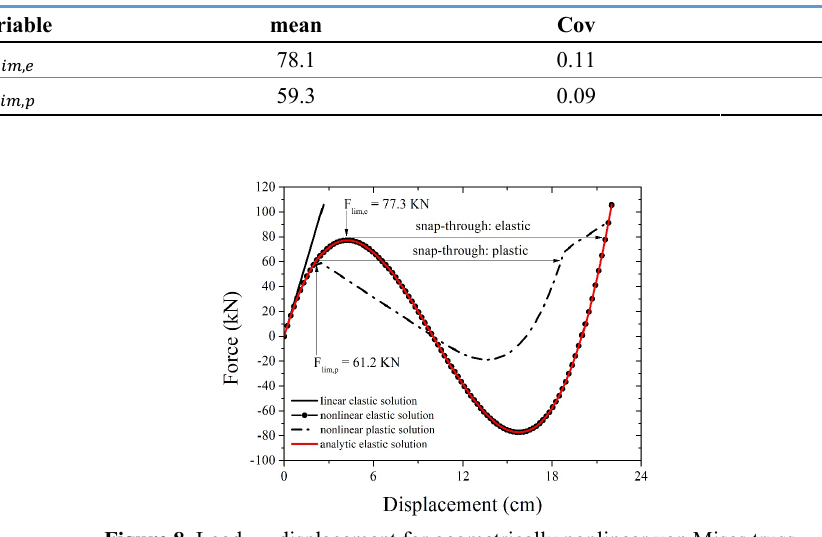
Figure 8. Load vs . displacement for geometrically nonlinear von Mises truss.